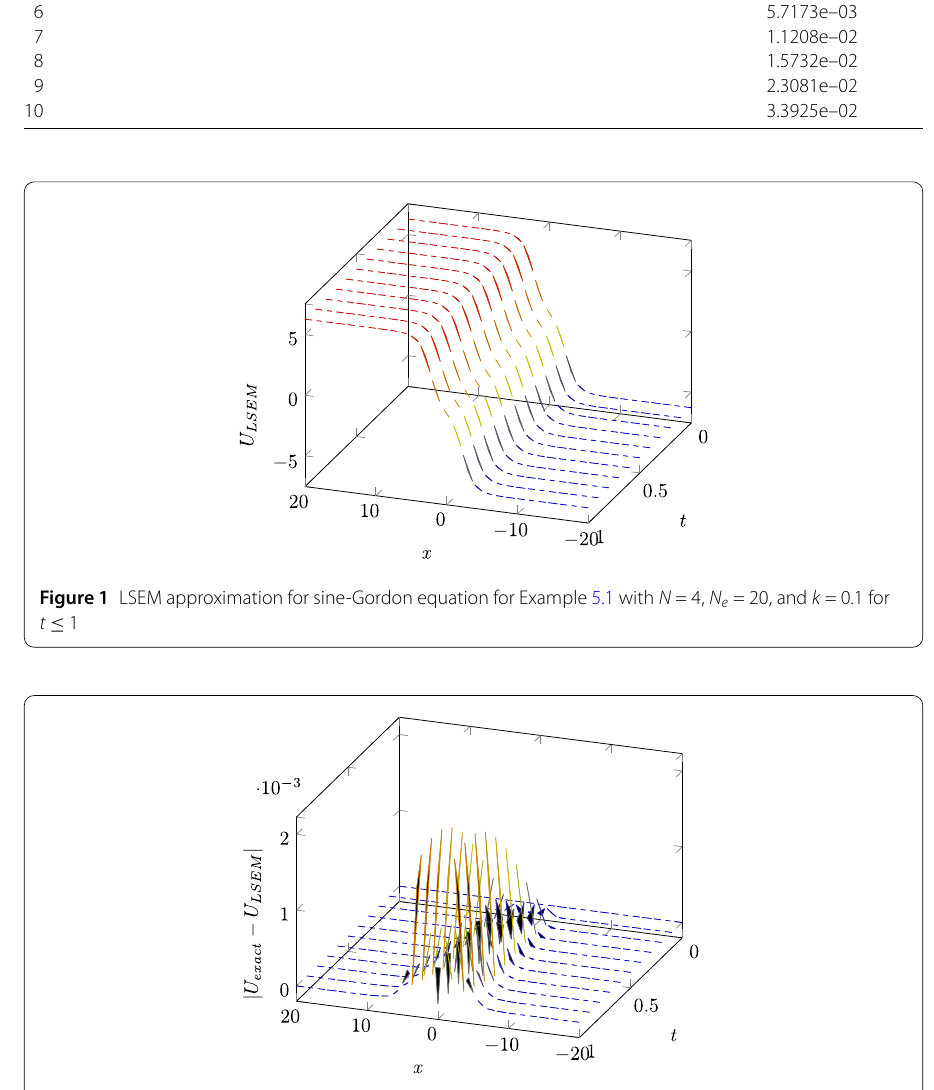
Figure 2 Absolute error for sine-Gordon equation for Example 5.1 with N = 4, N e = 20, and k =